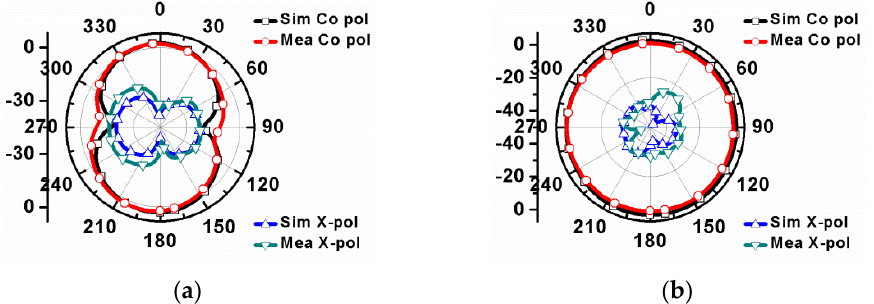
Figure 25. Far-field patterns of the communication antenna linked with port 2 at ( a ) 3 GHz (XZ) and ( b ) 3 GHz (YZ).